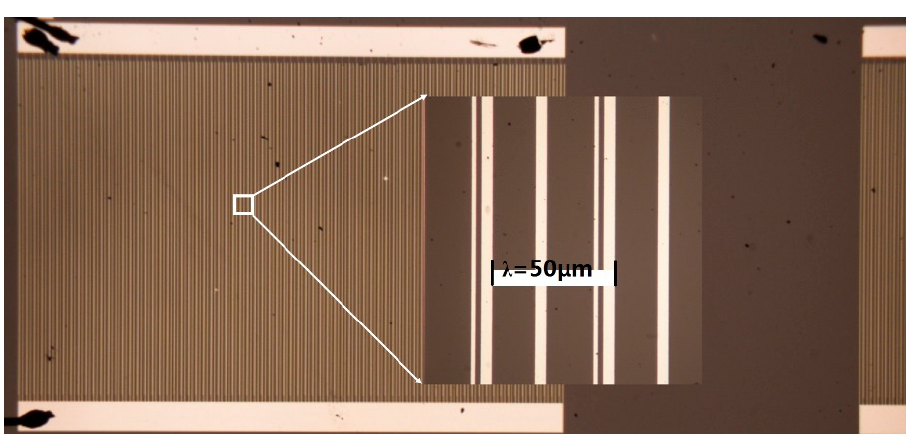
Figure 8. Image of the fabricated test device with transducers face-to-face.